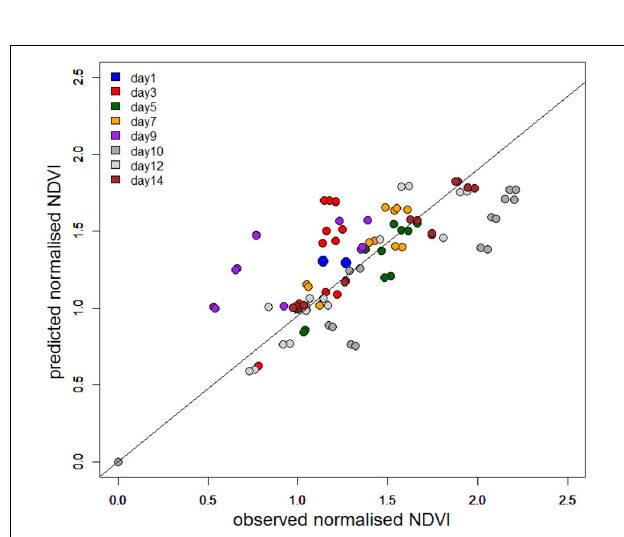
FIGURE 8 | Predicted normalized NDVI using the model of Pinckney and Zingmark (1991) against normalized NDVI from field